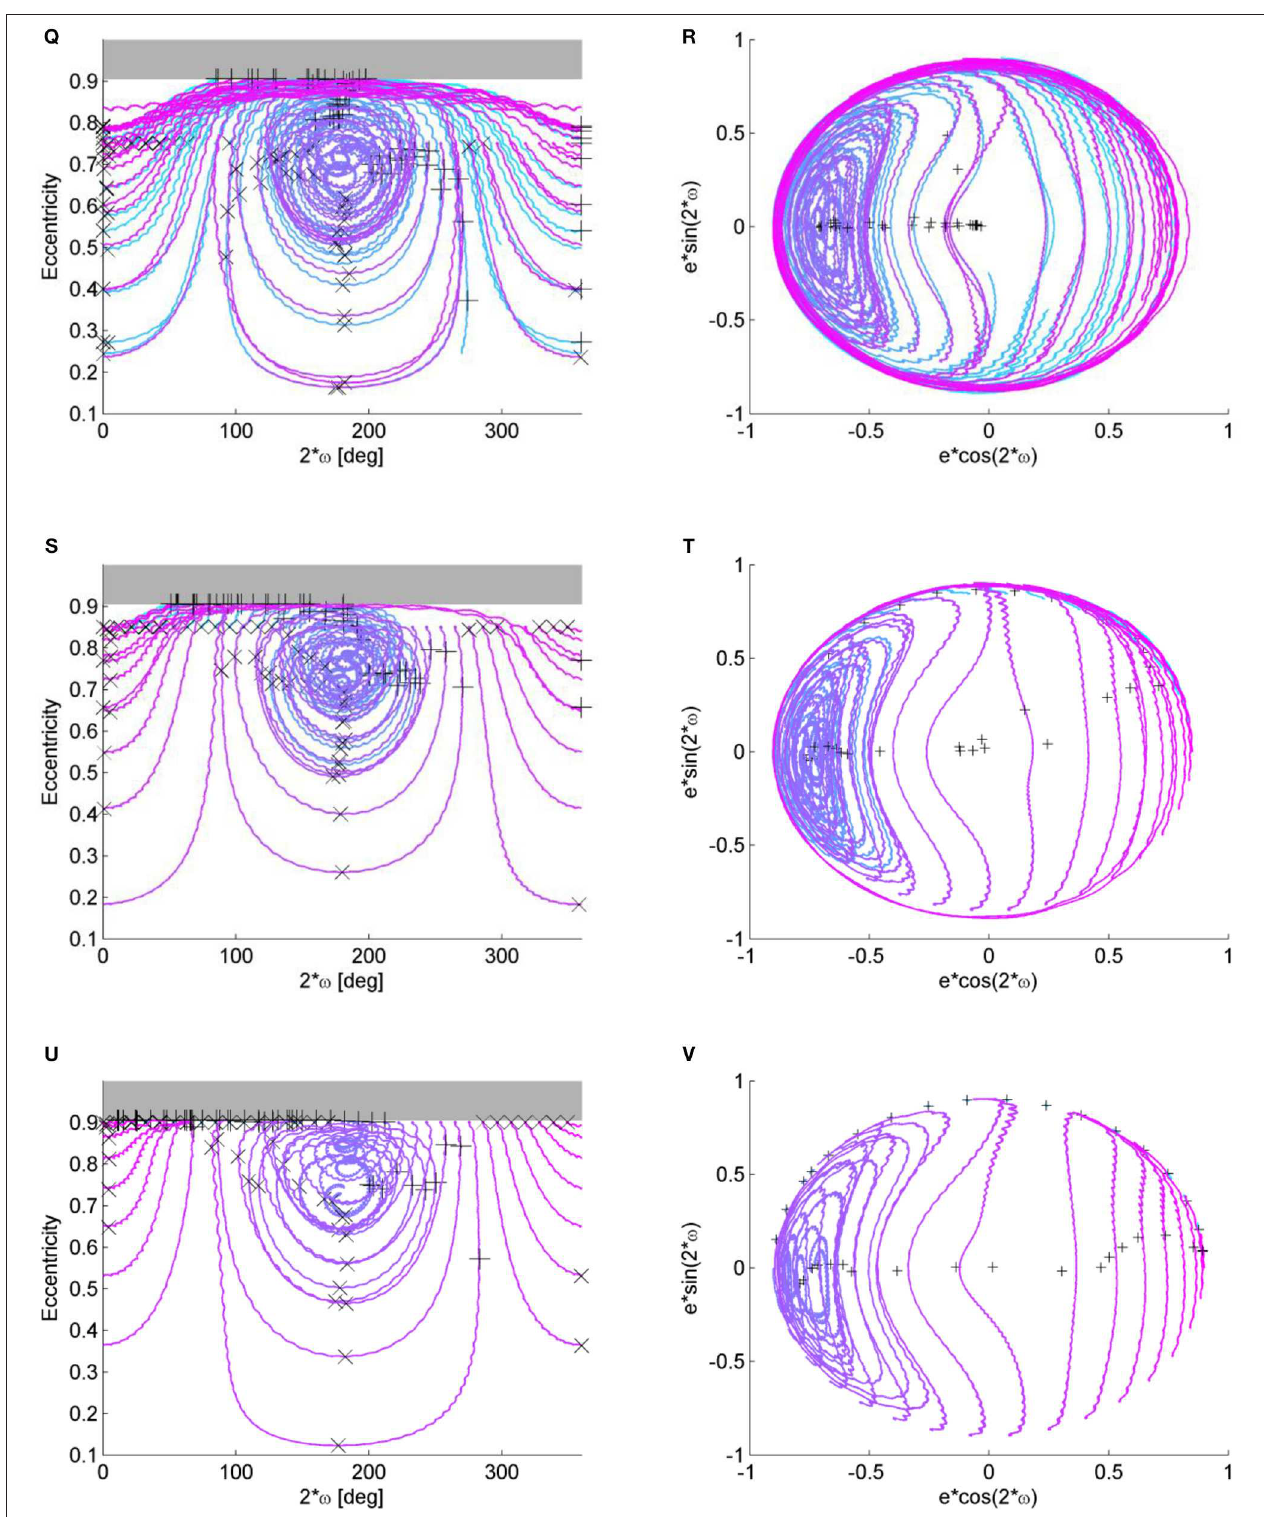
FIGURE 9 | Maps for initial inclination with respect to the Moon’s plane of 64.28 ◦ and semi-major axis equal to 67045.39km. The initial inclination and the argument of the perigee are measured with respect to the Moon plane. (A) Eccentricity-2 ω plot: e 0